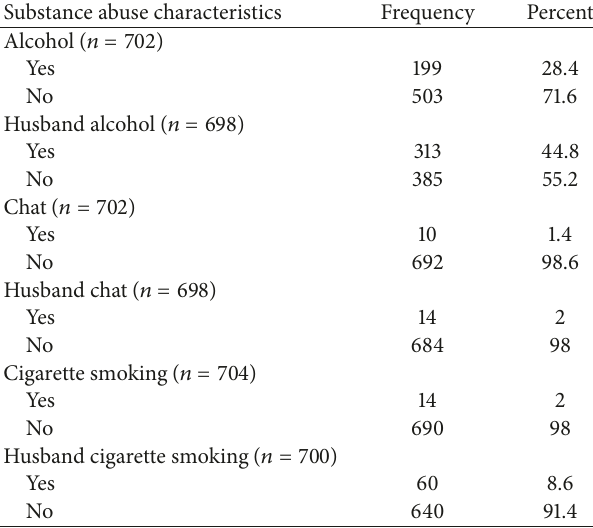
Table 2: Substance abuse related characteristics of the respondents and their partners in Arba Minch Zuria District, Ethiopia,